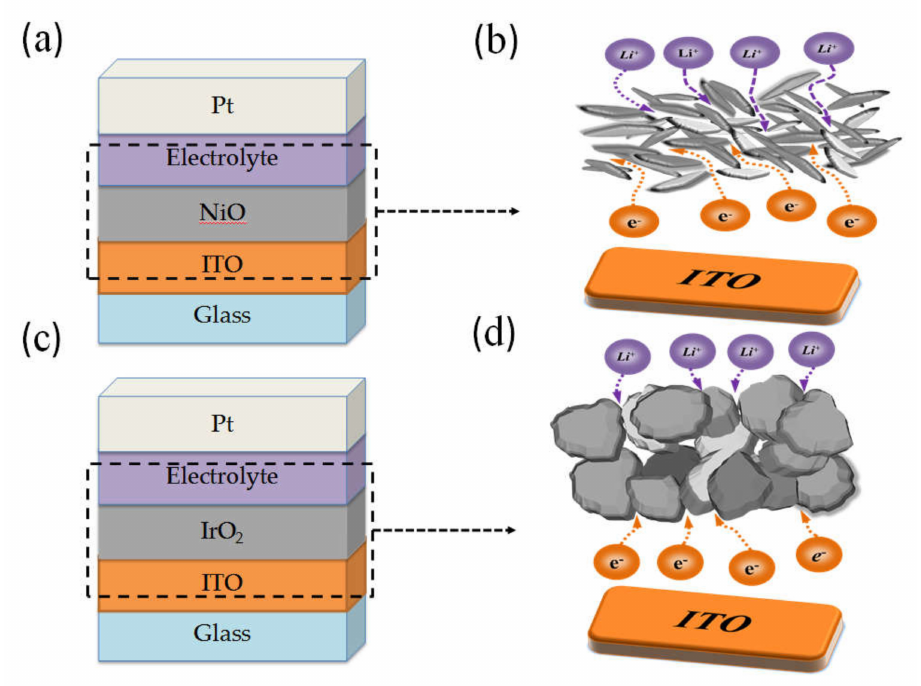
Figure 6. The schematics of Li ions path through surface morphology with different grain type ( a ) IrO 2 electrode device ( b ) IrO 2 electrode ( c ) NiO electrode device ( d ) NiO